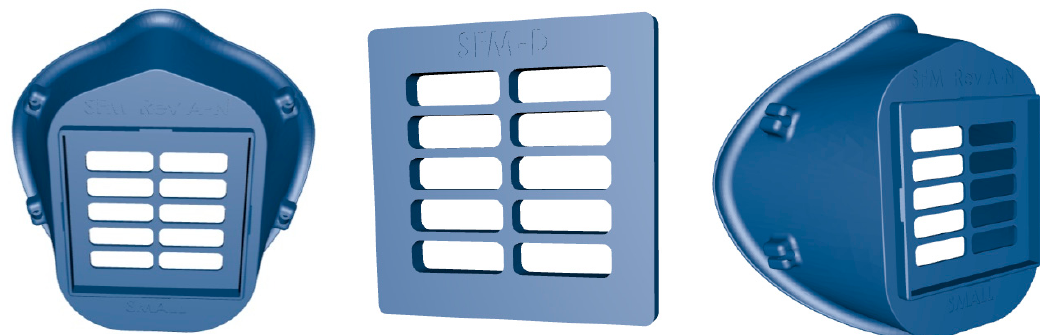
Figure 10. A stopgap face mask made of Nylon .